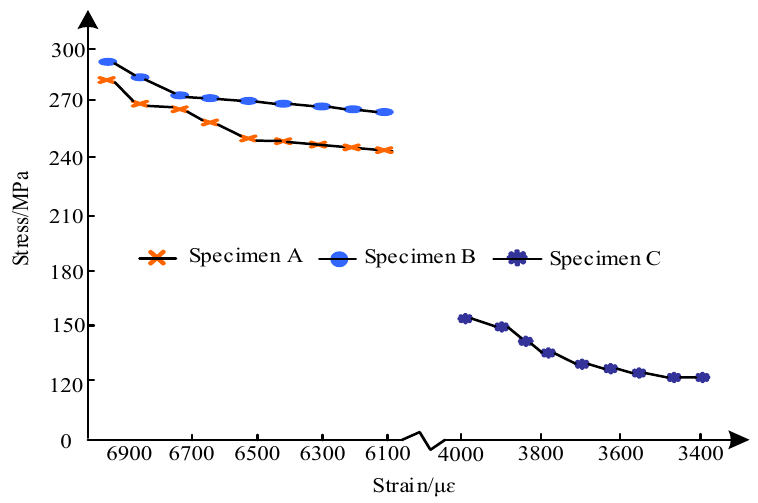
Figure 5. Stress–straincurve of bolt specimen.